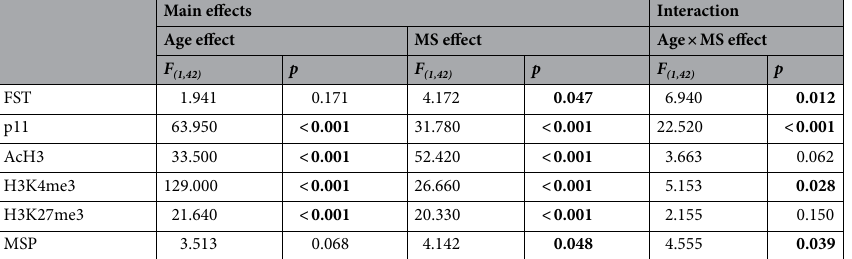
Table 1. Summary of statistical analysis by two-way ANOVA. Bold values denote statistical significance at the p < 0.05 level. Ac-H3: histone H3 acetylation; ANOVA: analysis of variance; FST: forced swimming